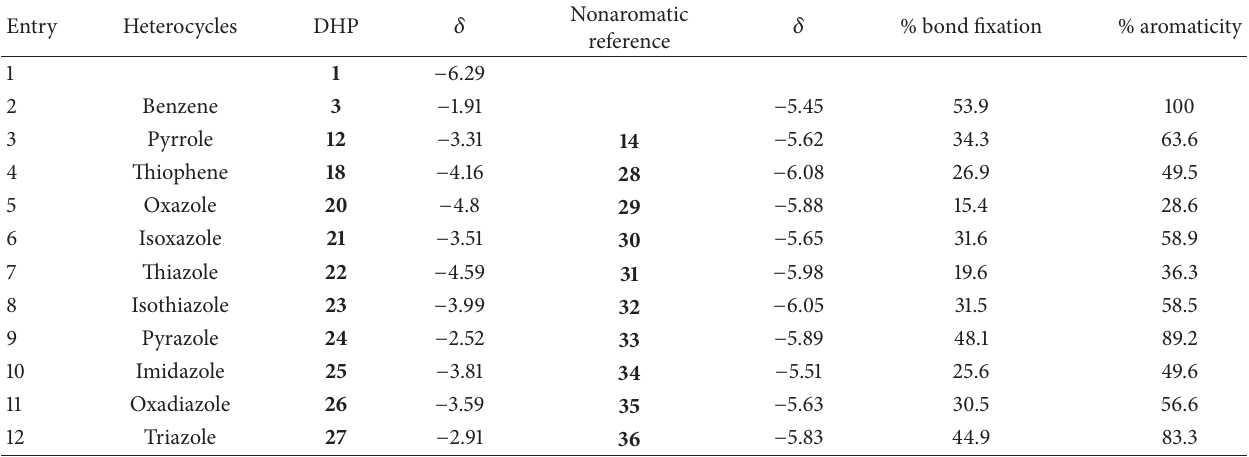
Table 2: 1 H NMR chemical shifts (calculated) of dihydropyrenes and nonaromatic reference models, % aromaticities of five membered heterocycles, calculated through (5).